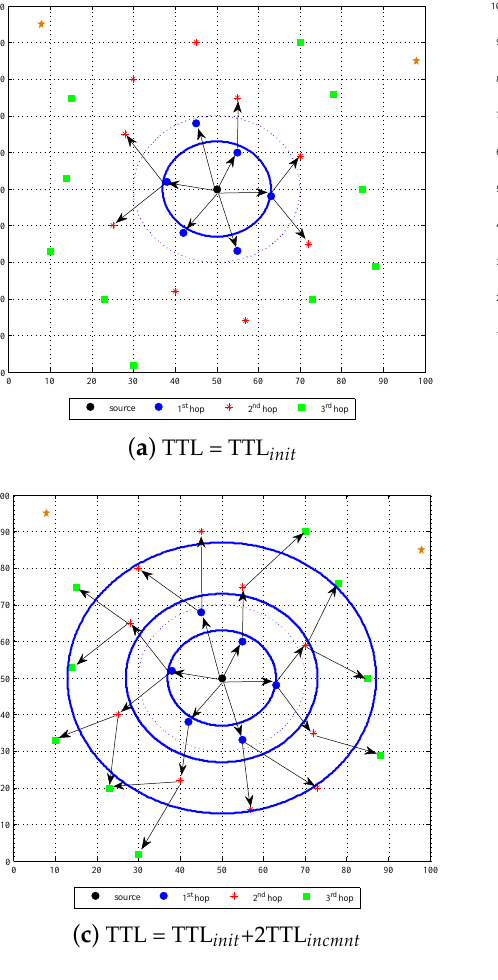
Figure 1. Forwarding of RREQ in EDS. Table 2. Area of CRB and